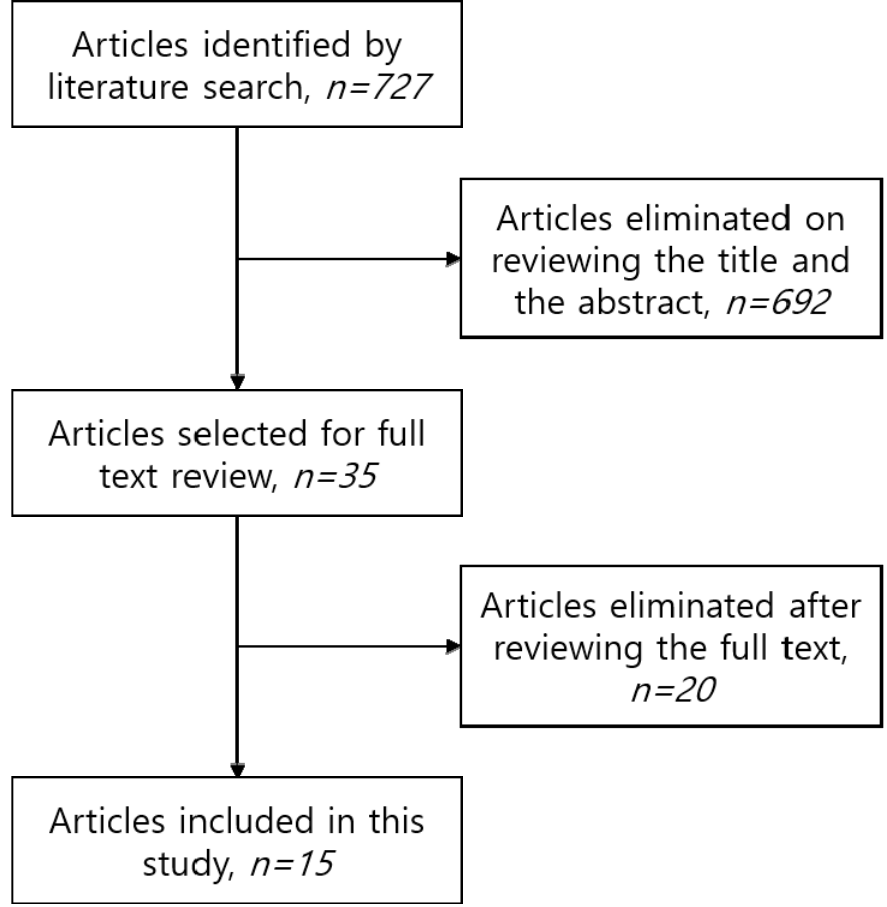
Figure 1. Flow chart for study selection.